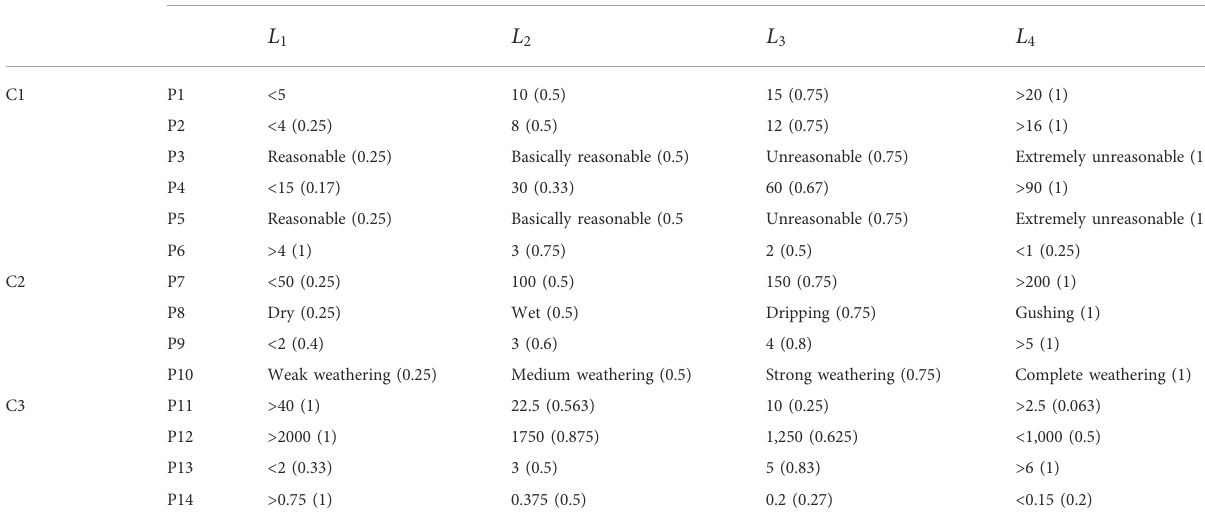
TABLE 2 The classi fi cation standards of tunnel